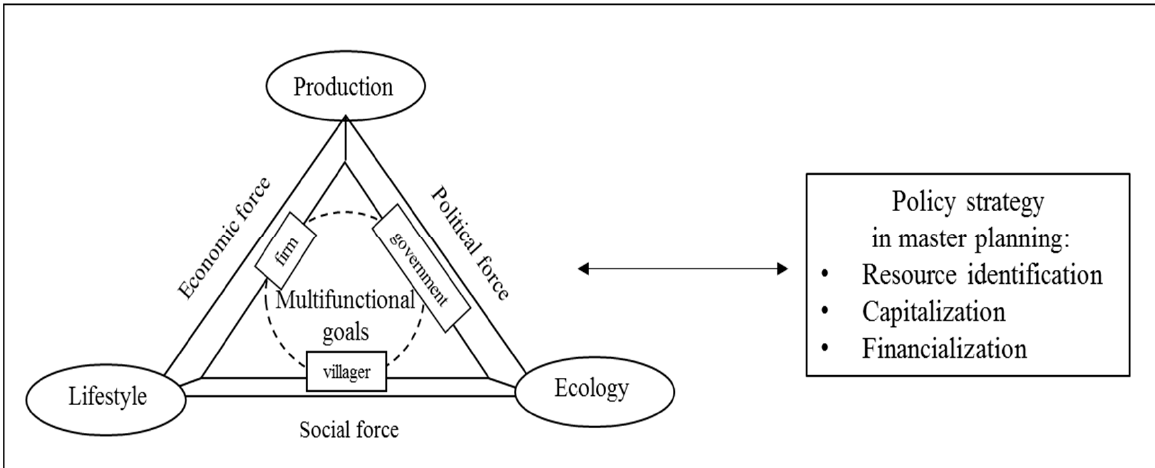
Figure 1. Conceptual framework of multifunctional goals in the master plan.